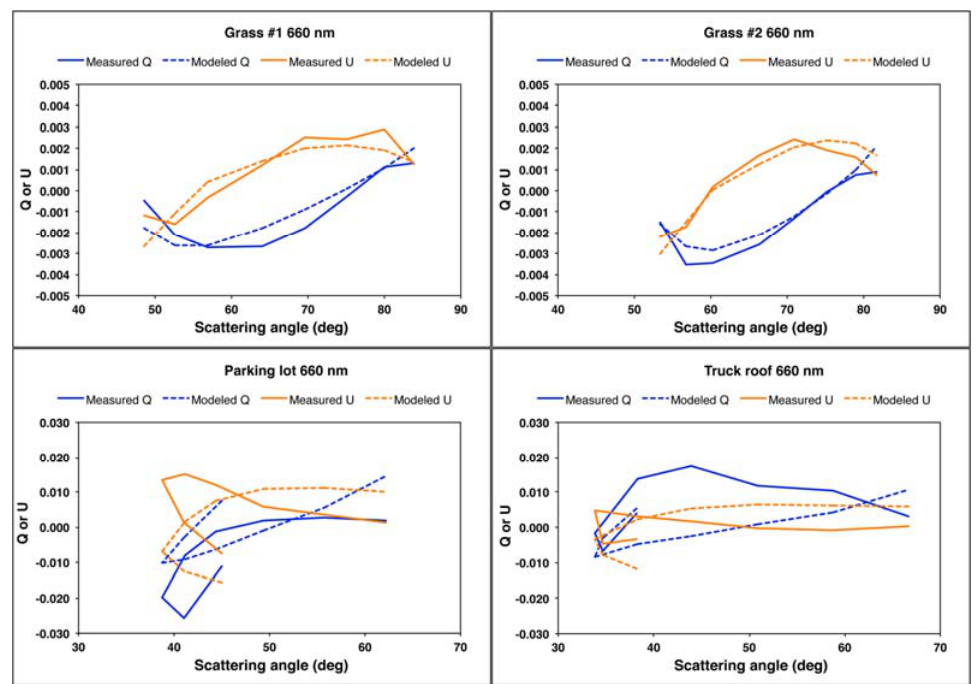
Figure 7. Q and U measured by GroundMSPI at 660 nm as a function of scattering angle for the four targets identified in Figure 4 (solid lines), along with values implied by the model for I derived in Step 1 of the modeling (dashed pol